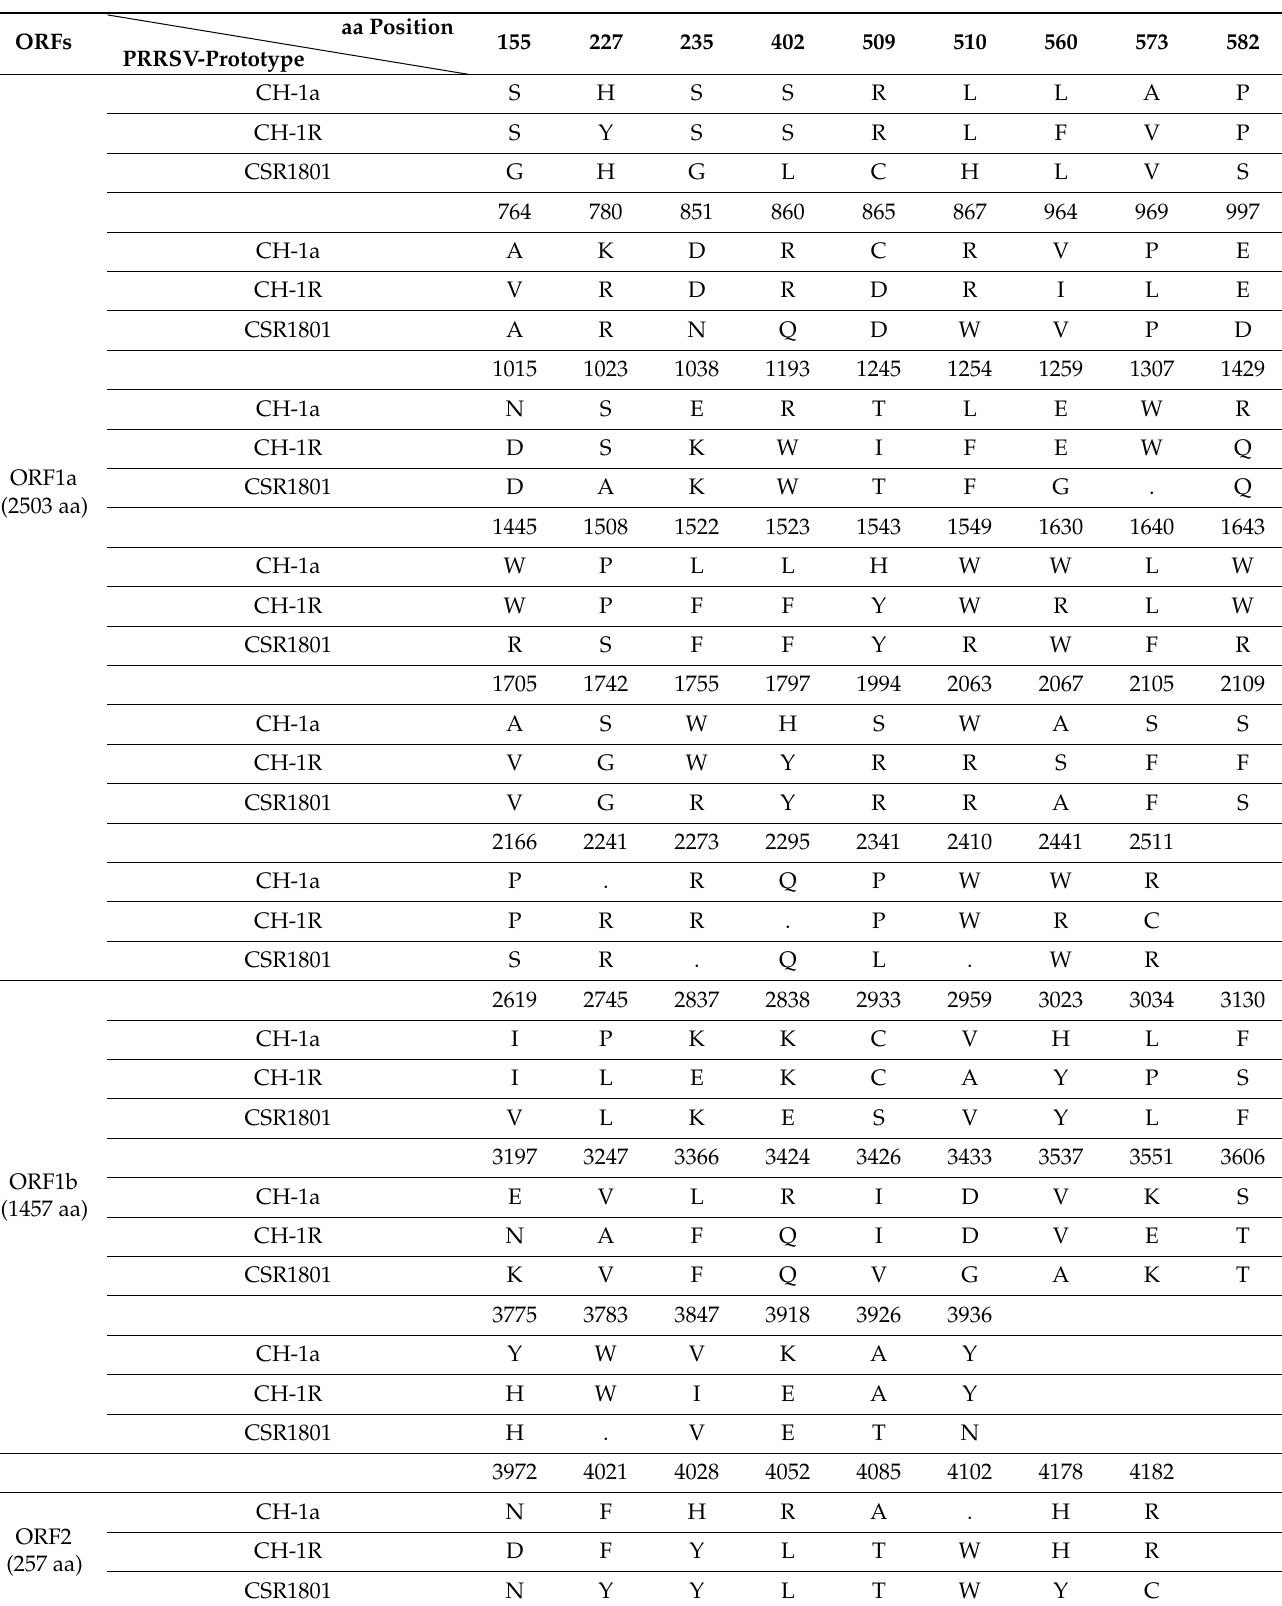
Table 2. Detailed comparison of the amino acid changes in the CSR1801 strain with the CH-1a and CH-1R